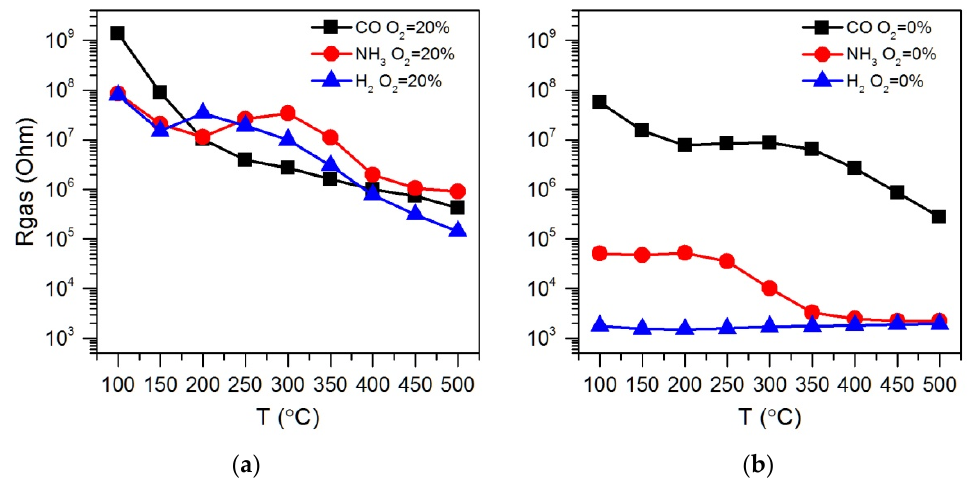
Figure 5. Temperature dependences of ZnO/Pd resistance in the presence of 100 ppm of CO, NH 3 or H 2 in dry atmosphere (RH = 0%) with different oxygen backgrounds 20% O 2 ( a ) and 0.0005% O 2 ( b ).